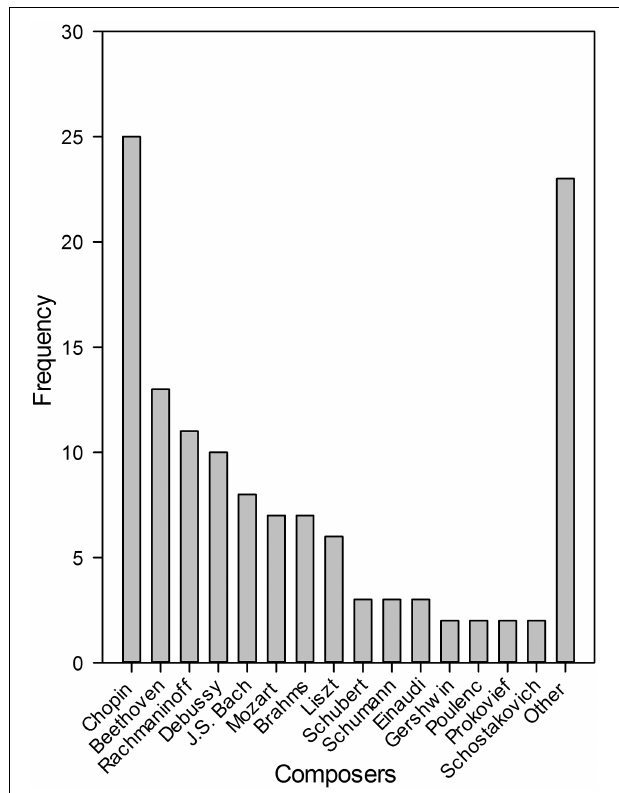
FIGURE 2 | Frequency distribution of composers who repeatedly induced flow states in a sample of piano performance students ( N = 69). More than one name could be